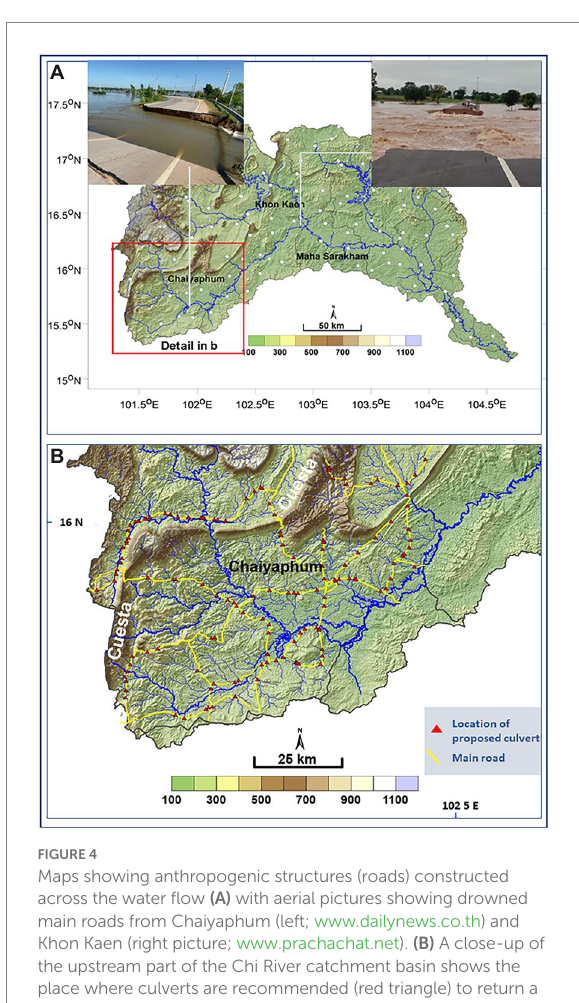
FIGURE 4 Maps showing anthropogenic structures (roads) constructed across the water flow (A) with aerial pictures showing drowned main roads from Chaiyaphum (left; www.dailynews.co.th) and Khon Kaen (right picture; www.prachachat.net). (B) A close-up of the upstream part of the Chi River catchment basin shows the place where culverts are recommended (red triangle) to return a natural water flow during